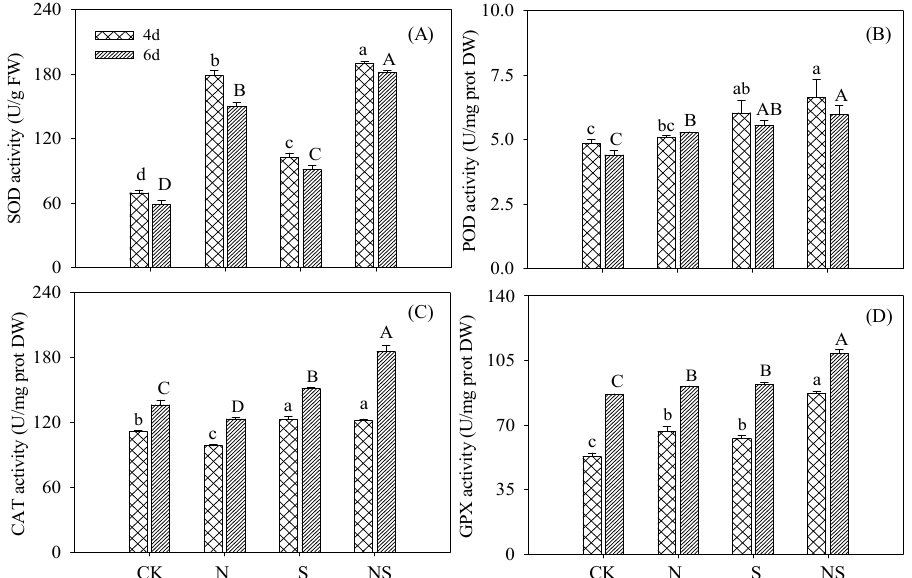
Figure 3. Changes in ( A ) superoxide dismutase (SOD), ( B ) peroxidase (POD), ( C ) catalase (CAT), and ( D ) glutathione peroxidase (GPX) activity in germinating soybeans. Lowercase letters reflect the significance of differences in index among treatments of 4-day germinating soybeans and capital letters reflect the significance of differences in index among treatments of 6-day germinating soybeans ( p < 0.05). CK, Control; N, NaCl; S, Spd; NS, NaCl + Spd.